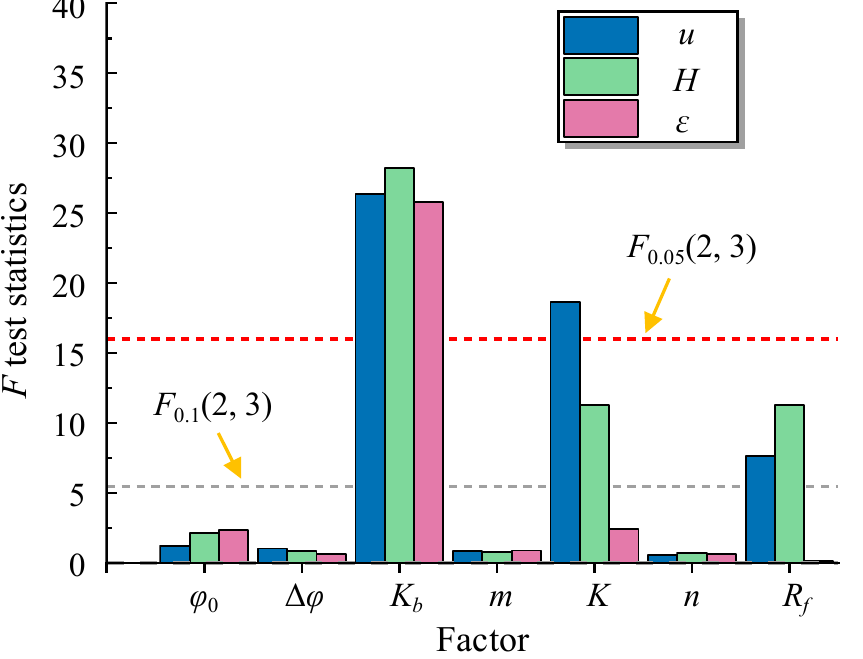
Figure 12. ANOVA results of each parameter in secondary rockfill zone to different indexes.